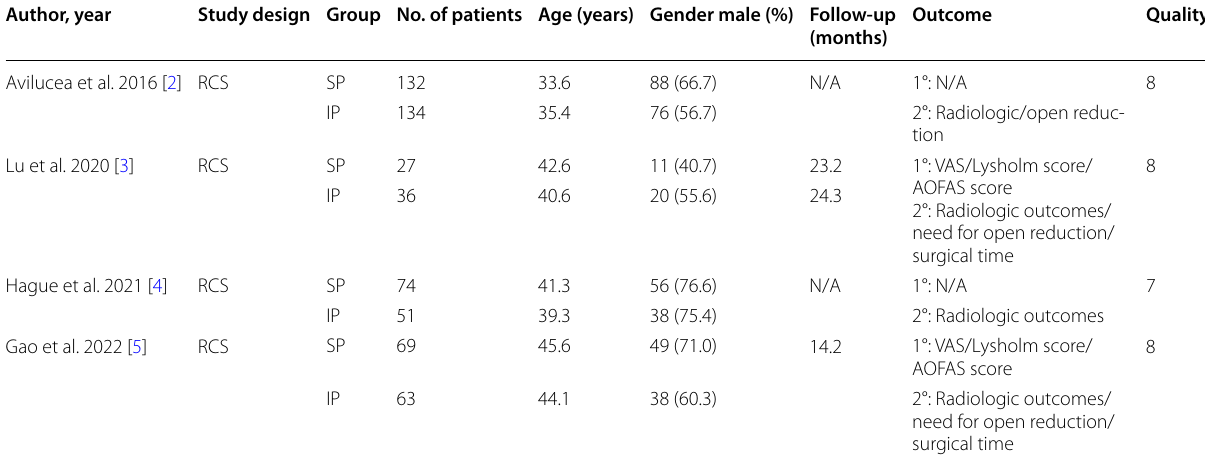
AOFAS American Orthopedic Foot and Ankle Society, IP infrapatellar, N/A not available, No . number, RCS retrospective cohort study, SP suprapatellar, VAS visual analogue scale